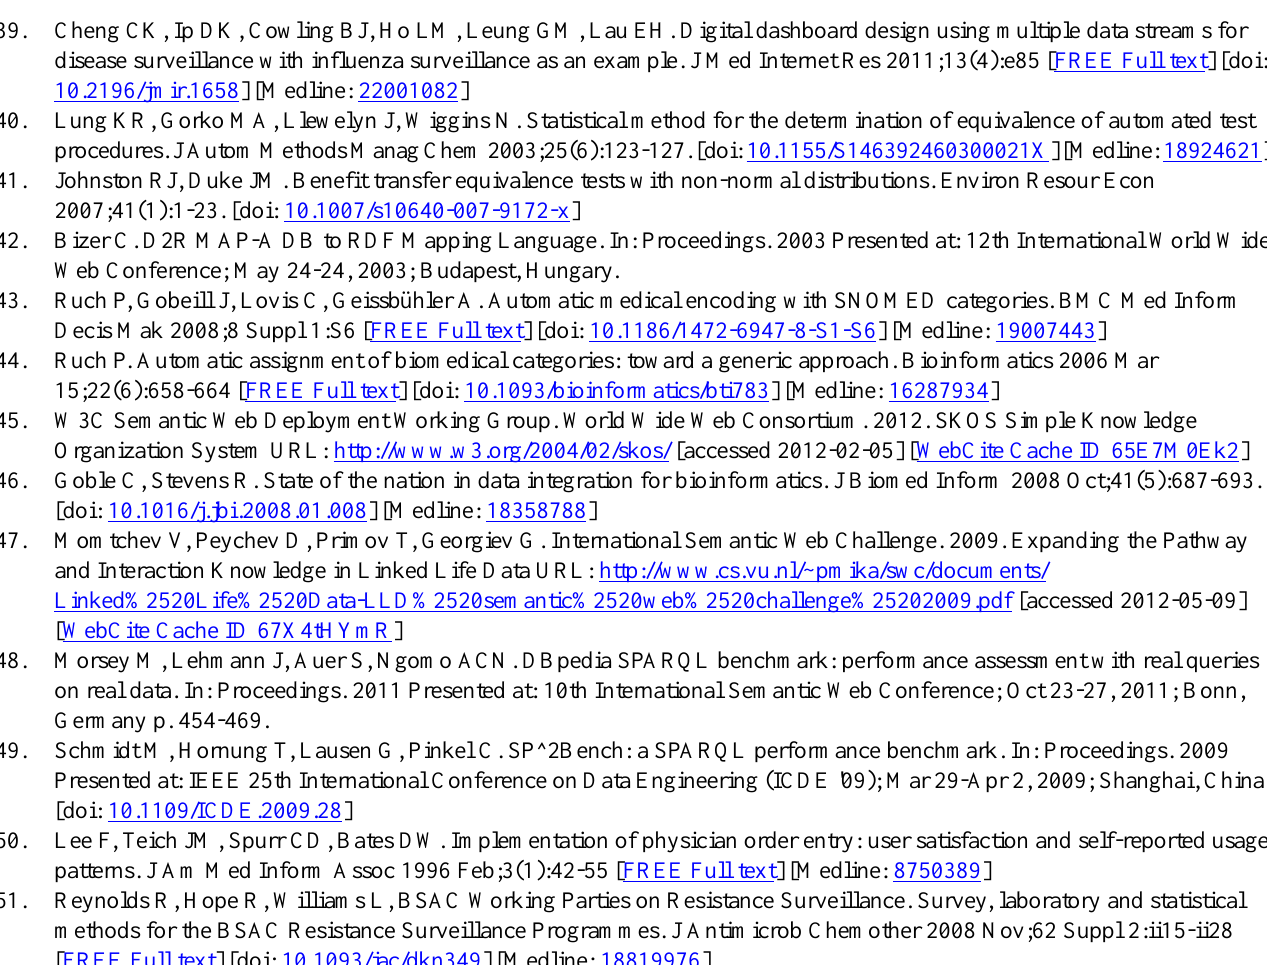
Abbreviations ARTEMIS: Antimicrobial Resistance Trend Monitoring System CI: confidence interval DebugIT: Detecting and Eliminating Bacteria Using Information Technology EARS-Net: European Antimicrobial Resistance Surveillance Network lCDR: local clinical data repository RDF: Resource Description Framework SEARCH: Sentinel Surveillance of Antibiotic Resistance in Switzerland SKOS: Simple Knowledge Organization System SNOMED-CT: Systematized Nomenclature of Medicine-Clinical Terms SPARQL: Simple Protocol and RDF Query Language WHO: World Health Organization WHO-ATC: World Health Organization- Anatomical Therapeutic